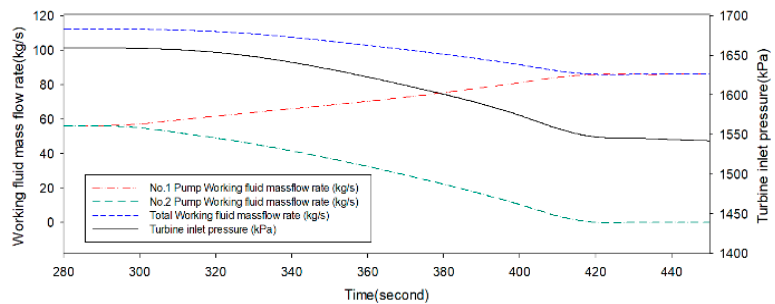
Figure 14. Inlet and outlet pressure gradient of working fluid pump.